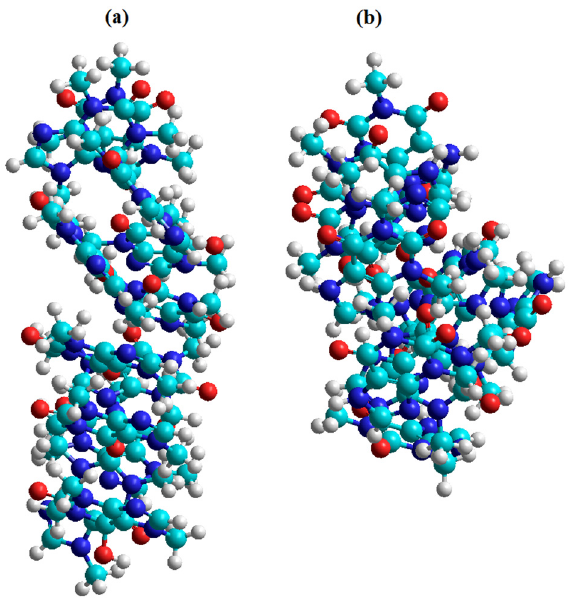
Figure 2. Optimized geometry representing ball shape for 12 caffeine molecules ( a ) and 12 theophylline molecules ( b